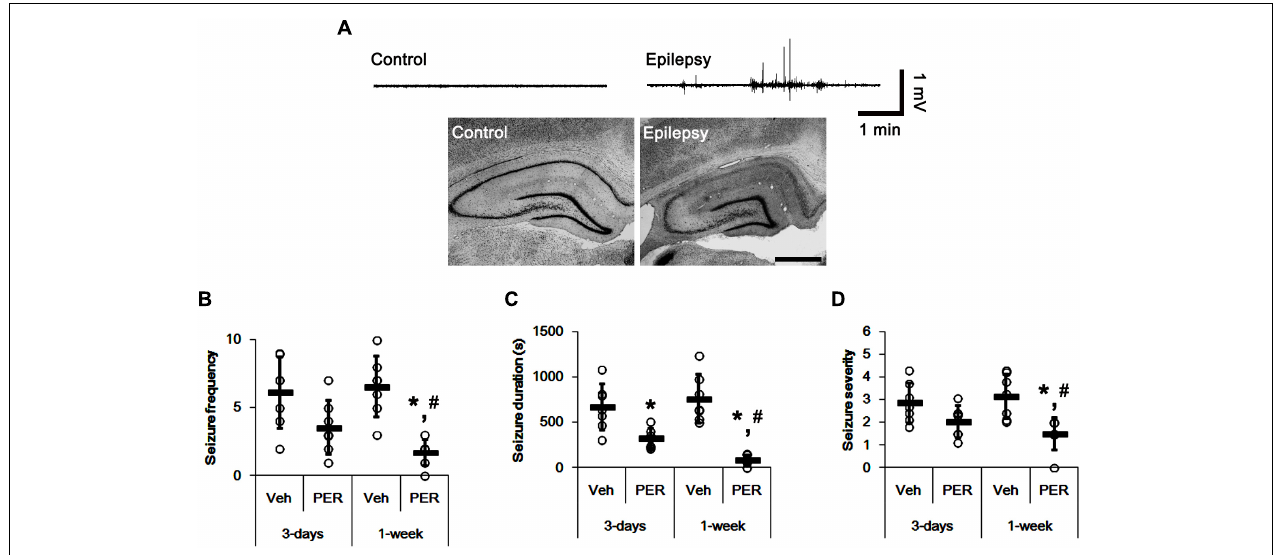
FIGURE 2 | The effect of perampanel on spontaneous seizure activity in epileptic rats. (A) Representative EEG traces and hippocampal images obtained from normal and epileptic rats. Bar = 400 µ m. (B–D) Quantitative values of seizure frequency (B) , total seizure duration (C) , and seizure severity (D) during 2 h of recording a day. Open circles indicate each individual value. Horizontal bars indicate mean value. Error bars indicate SD ( ∗ , # p < 0.05 vs. vehicle and 3-days perampanel treatment, respectively; n = 7, respectively).